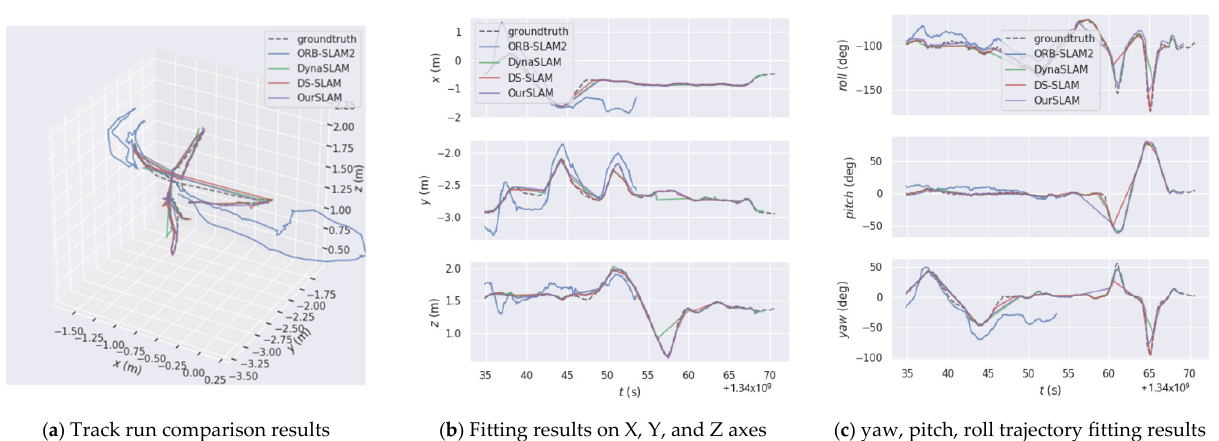
Figure 10. Comparison of ORB-SLAM2, DynaSLAM, DS-SLAM, and OurSLAM trajectory map operation results.